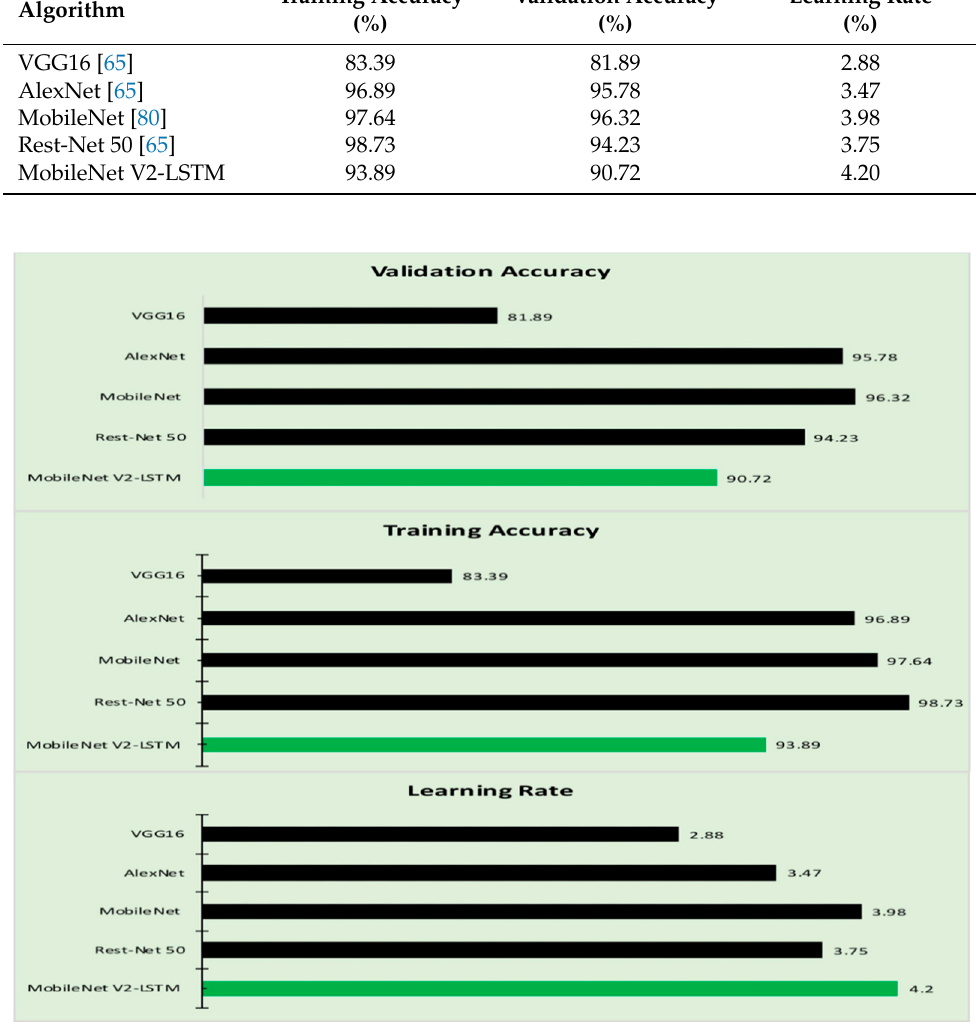
Figure 12. The hyperparameters of the proposed model.